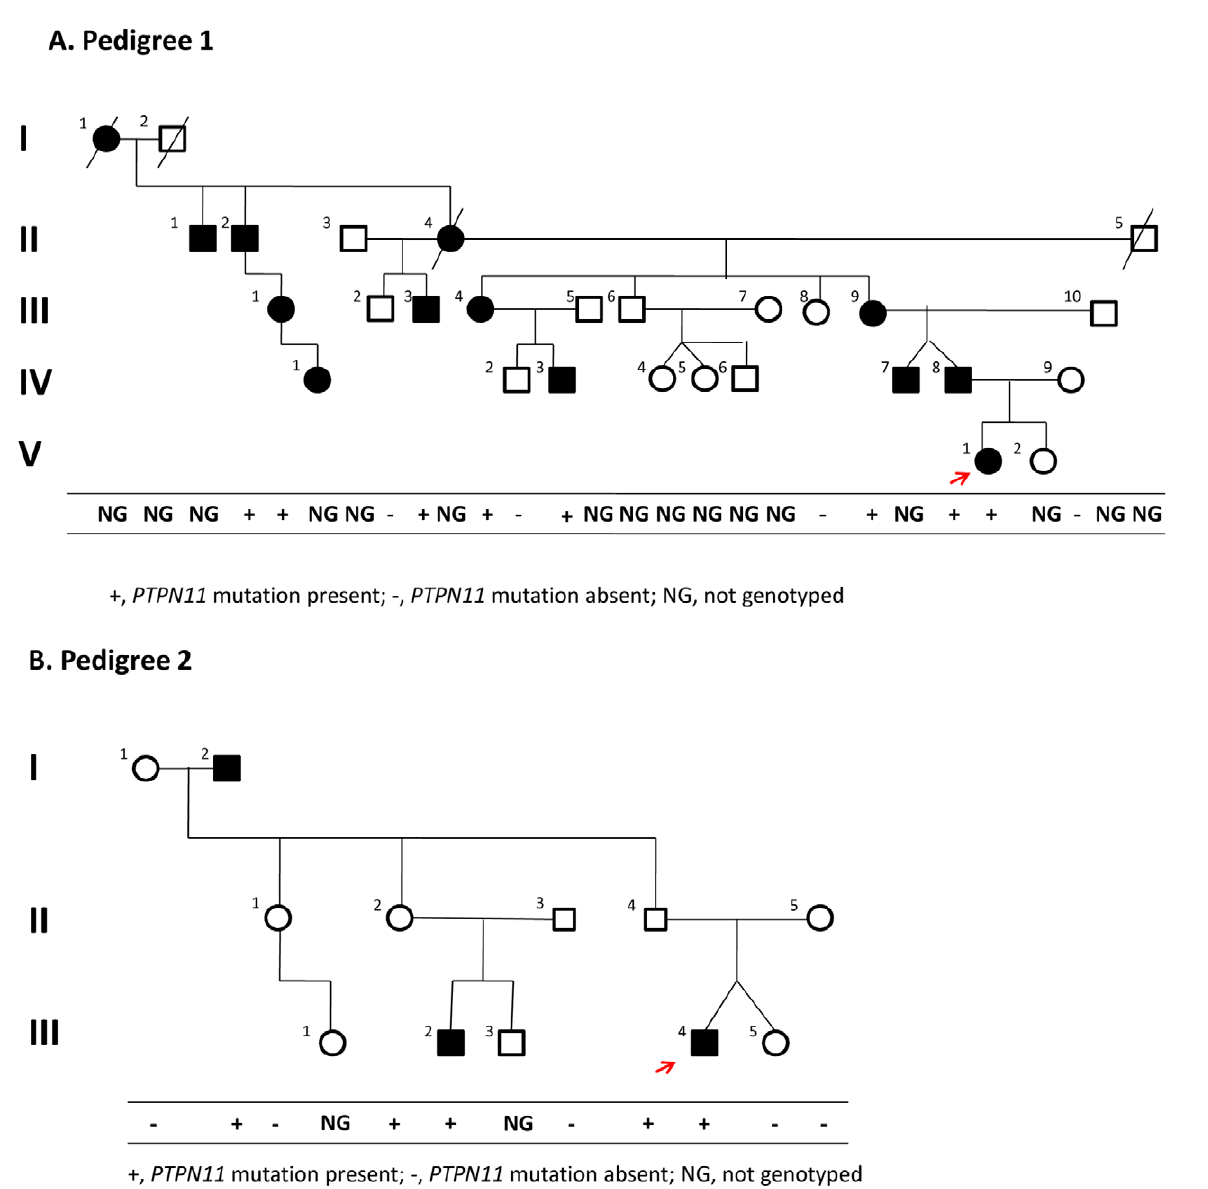
Figure 2. Pedigrees. Of families 1 (A) and 2 (B). The red arrow indicates the proband in each family. Segregation of the causal variant with the disease is shown in each family. Although III-1 and IV-1 in pedigree 1 were originally reported to be unaffected, we had the opportunity to